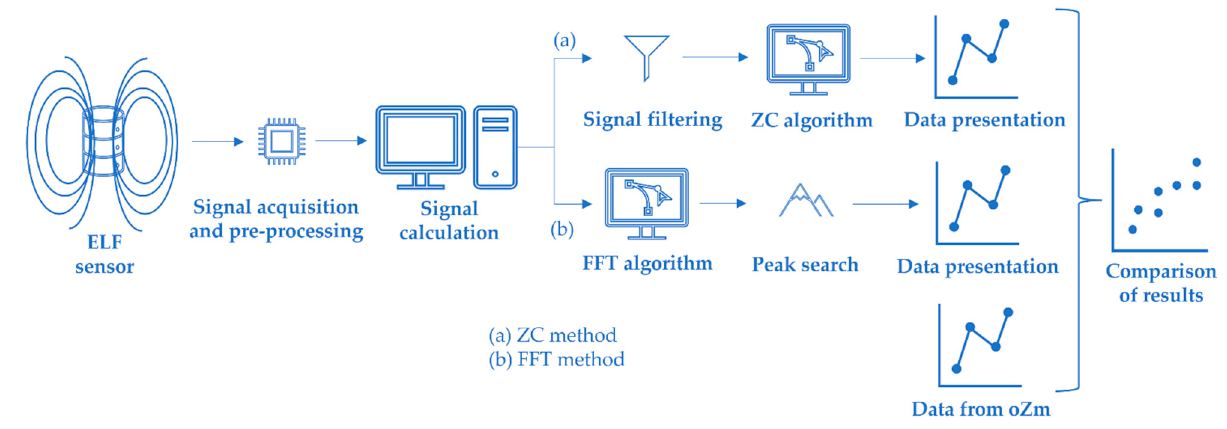
Figure 5. Diagram of the ZC and FFT algorithm used in this paper.